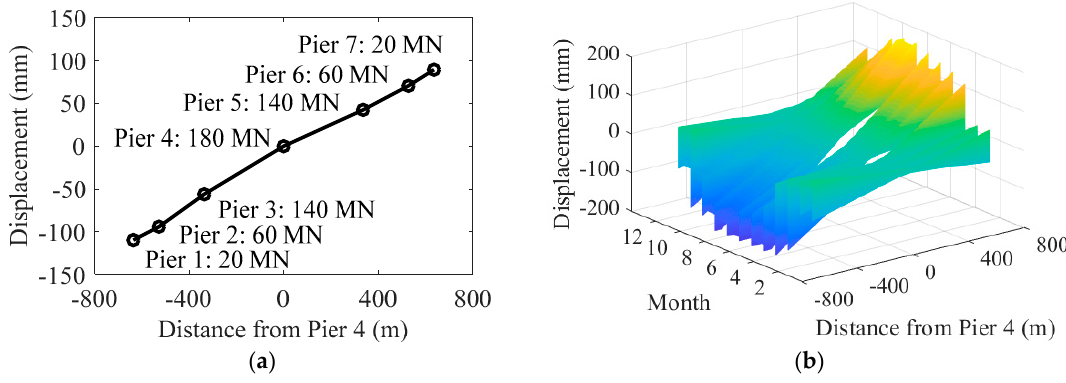
Figure 9. Longitudinal displacements of the bearings on Piers 1~3 and 5~7 versus their distances from Pier 4 in 2015: ( a ) annual average value with the capacity of bearings; ( b ) linear fitting line by each 1600 s of data.